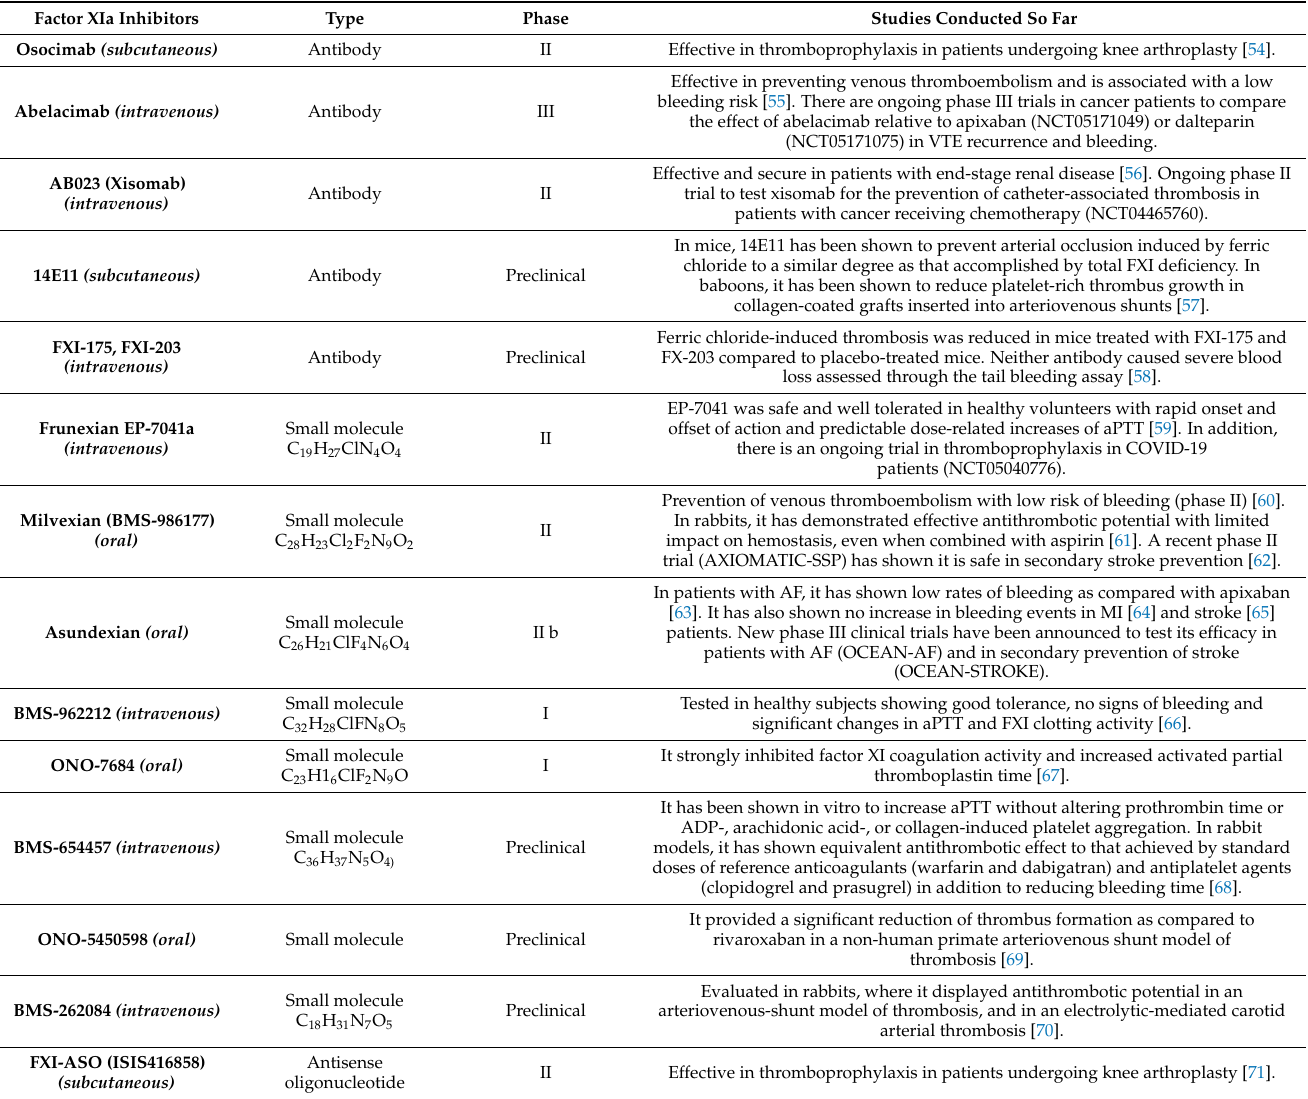
FXIa inhibitors and details the studies conducted so far to assess their efficacy and safety. VTE: venous thromboembolism; AF: atrial fibrilation; aPTT: activated partial thromboplastin time; MI: myocardial